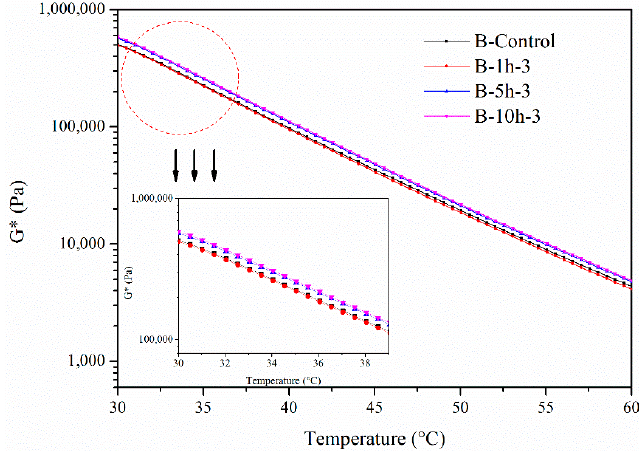
Figure 8. Complex modulus of B in the third layer’s bitumen for different aging times.